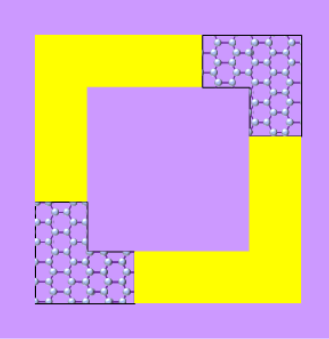
Figure 9. Metamaterial polarization converter structures based on double-split graphene ring [111].